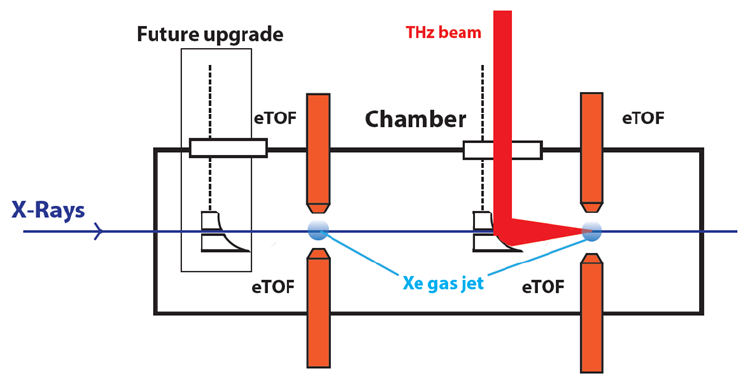
Figure 9. Schematic drawing of the photon arrival and length monitor (PALM)